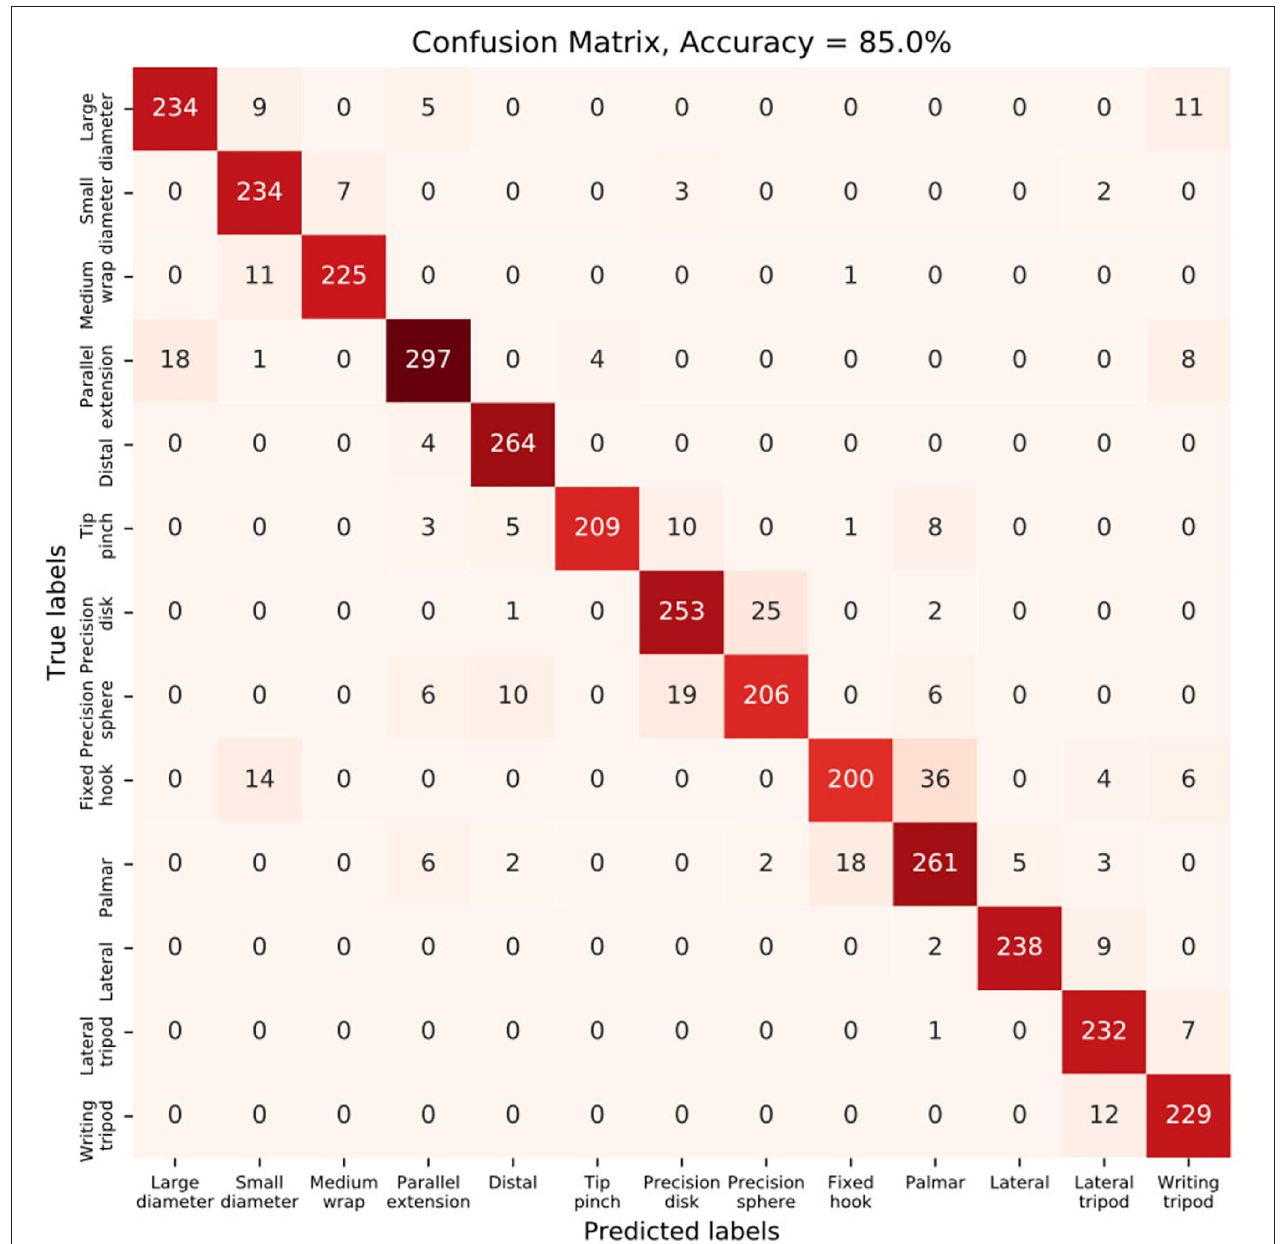
FIGURE 11 | Confusion matrix of the third strategy, during the pre-shaping period from t = − 743 ms to t = 0